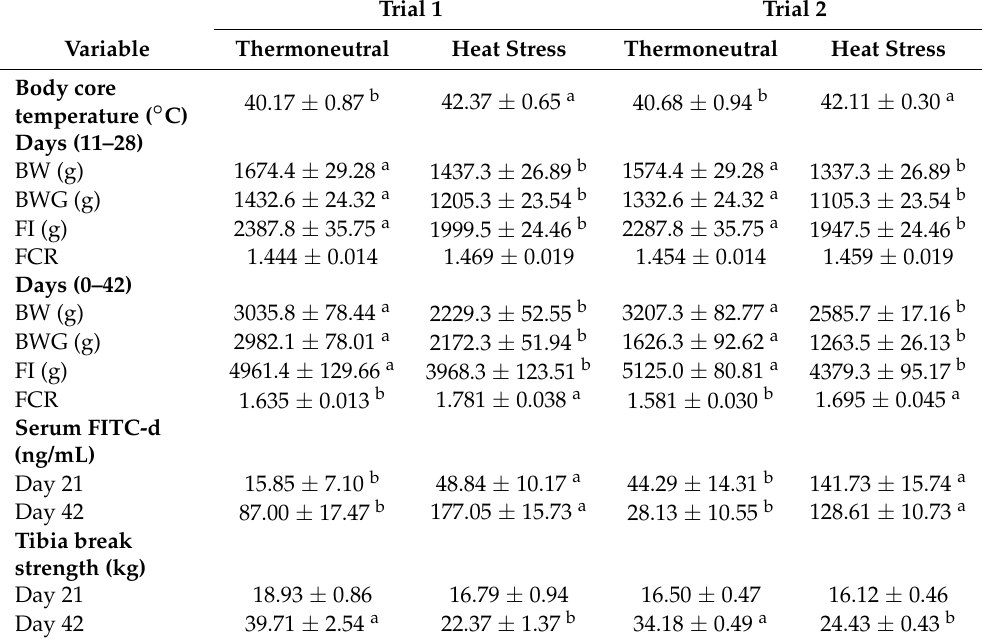
Table 1. Evaluation of body core temperature, body weight (BW), body weight gain (BWG), feed intake (FI), feed conversion ratio (FCR), serum FITC-d, and bone parameters in broiler chickens during cyclic heat stress in trials 1 and trial